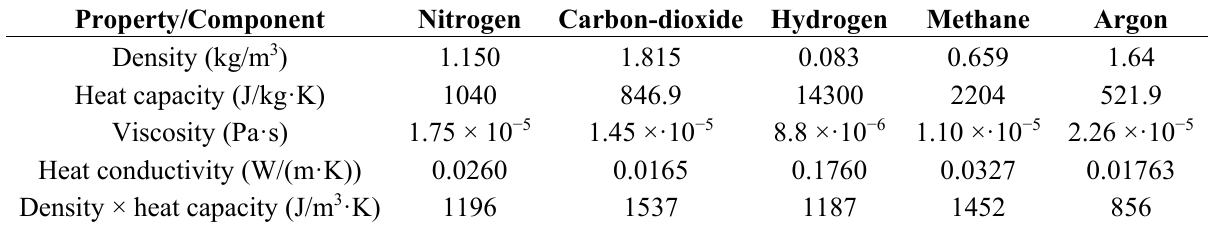
Figure 7. ( a ) Applied and measured volume fractions for a mixture composed of nitrogen, hydrogen and argon. ( b ) Applied and measured volume fractions for a mixture of methane, carbon dioxide and nitrogen. Table 1. Physical properties of gasses applied in the described